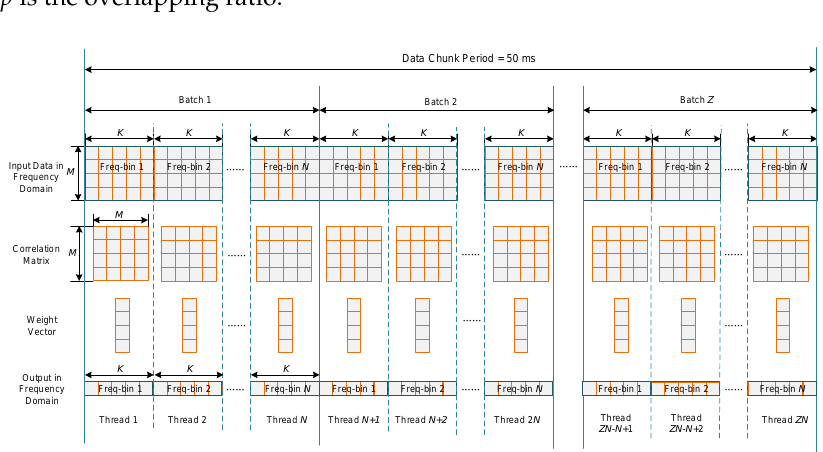
Figure 9. Data layout in the spatial-frequency adaptive processor (SFAP) after the FFT.